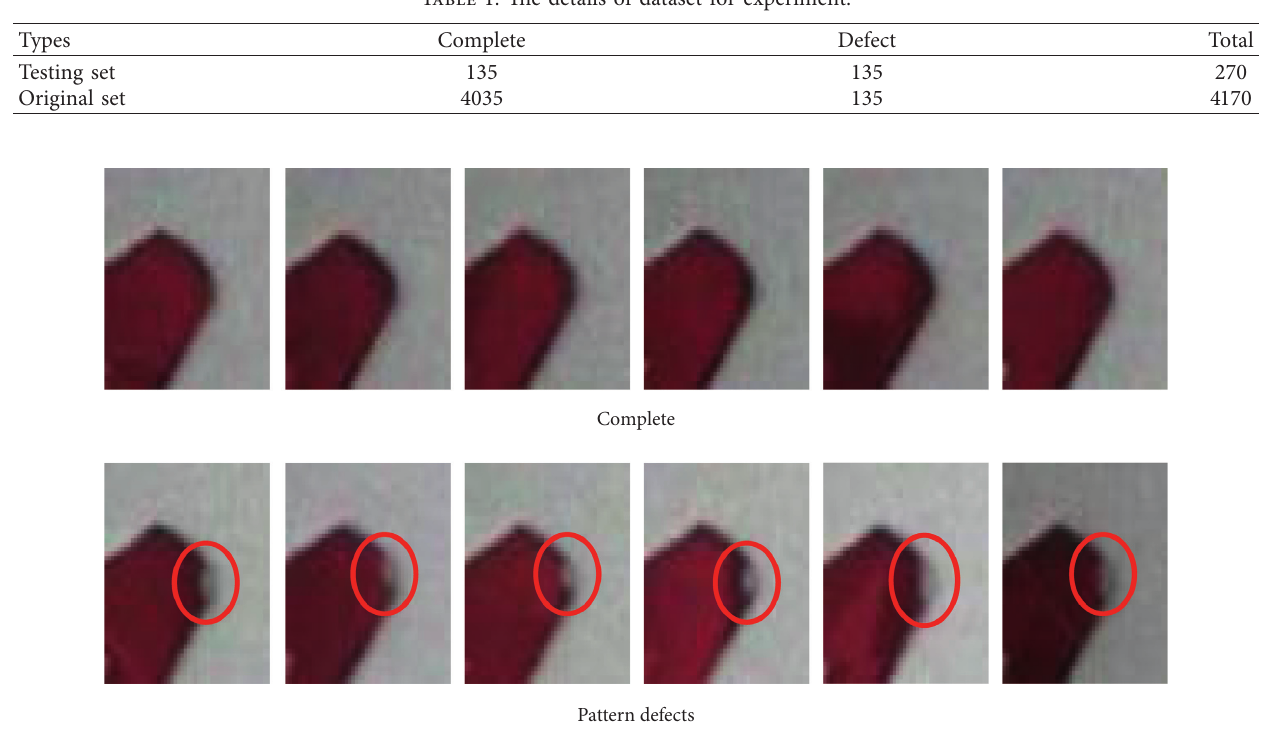
Figure 8: Dataset of some printing images used in this paper. Table 2: The confusion matrix and evaluation result of defect detection with different fusion sizes. Confusion matrix, accuracy, precision, and recall with different fusion sizes